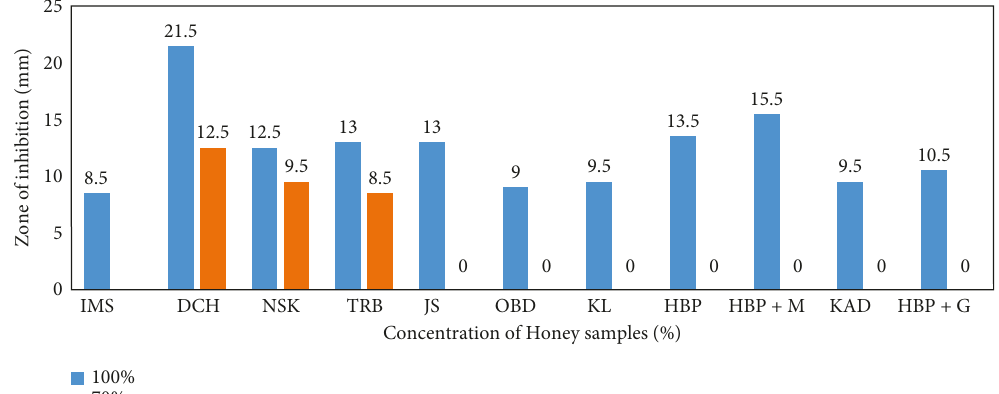
Figure 1: Antibacterial efficacy of selected honey on Staphylococcus aureus